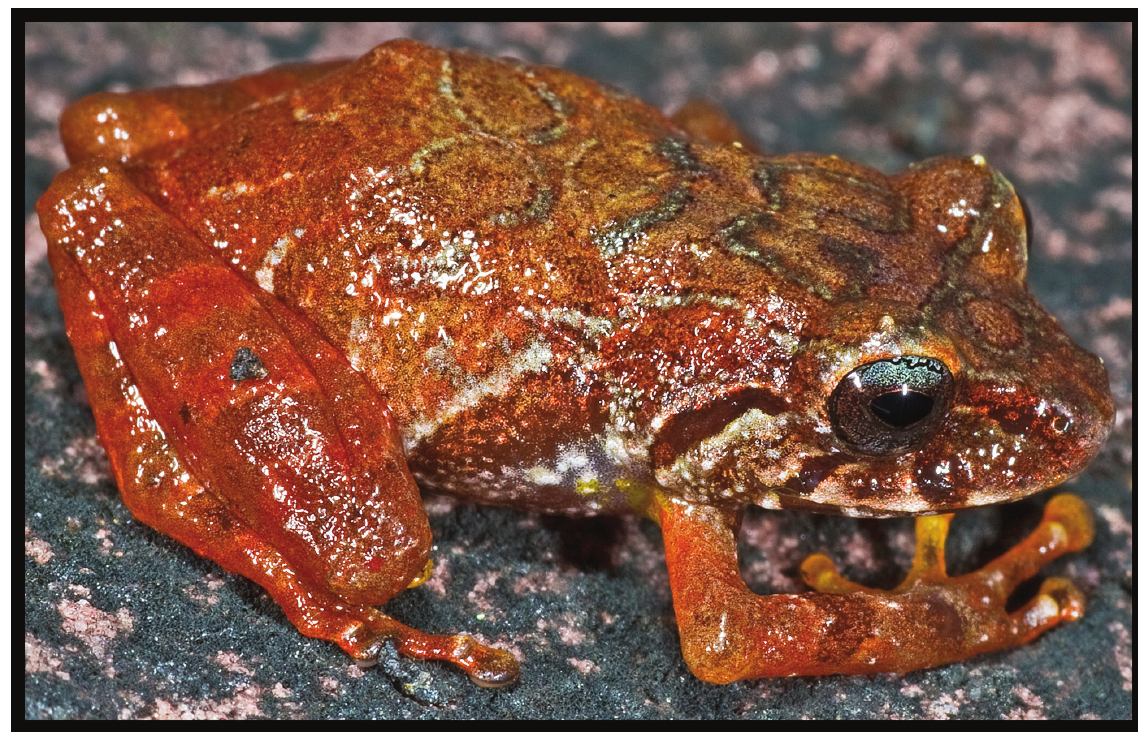
Fig. 5. Pristimantis jamescameroni sp. nov. Juvenile specimen (IRSNB 4164, 18.3 mm SVL). Photograph by the